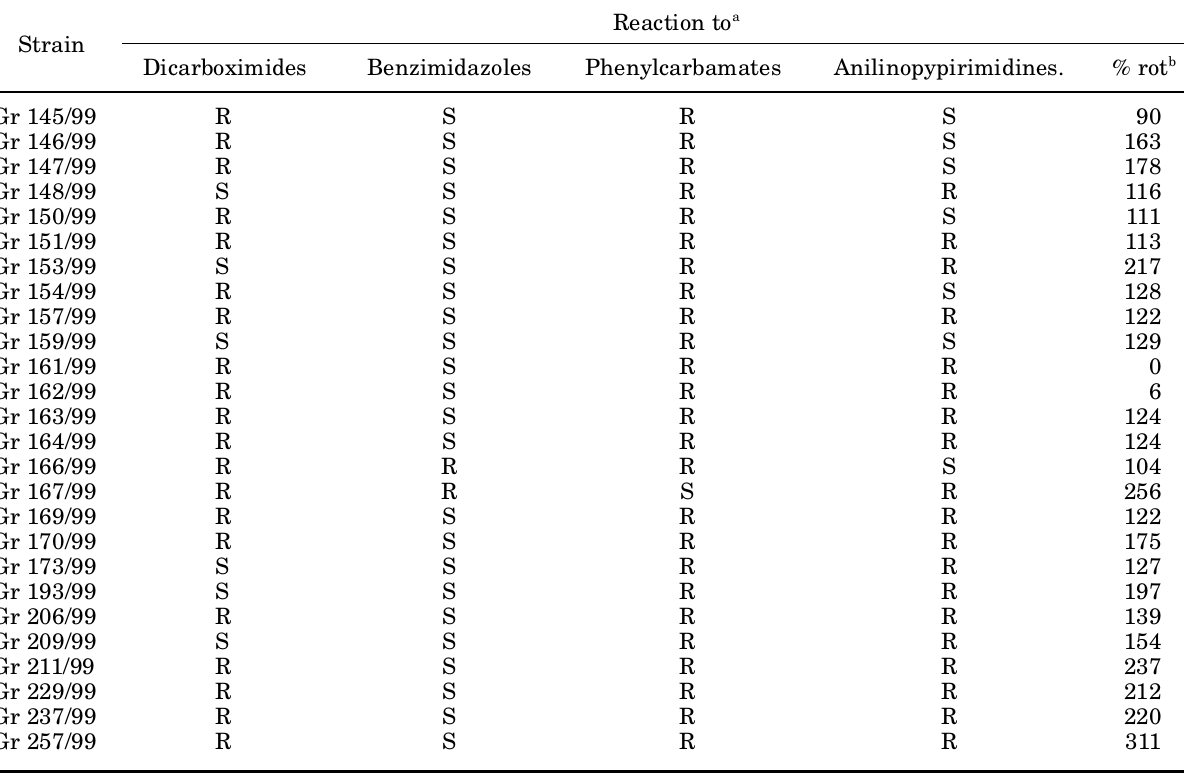
Table 8. ( continued from the preceding page )